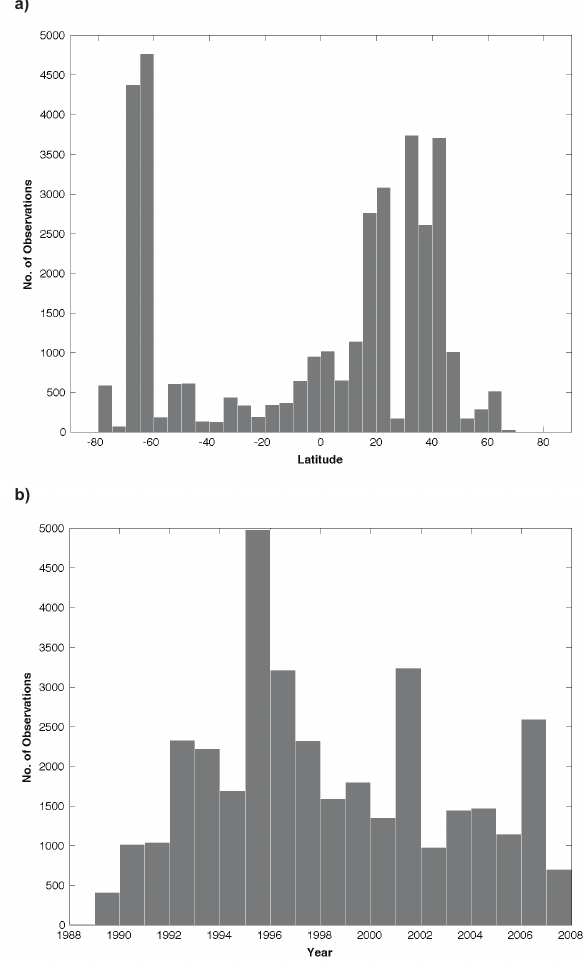
Figure 4. Number of MAREDAT TCHLA observations as a func- tion of (a) latitude and (b)